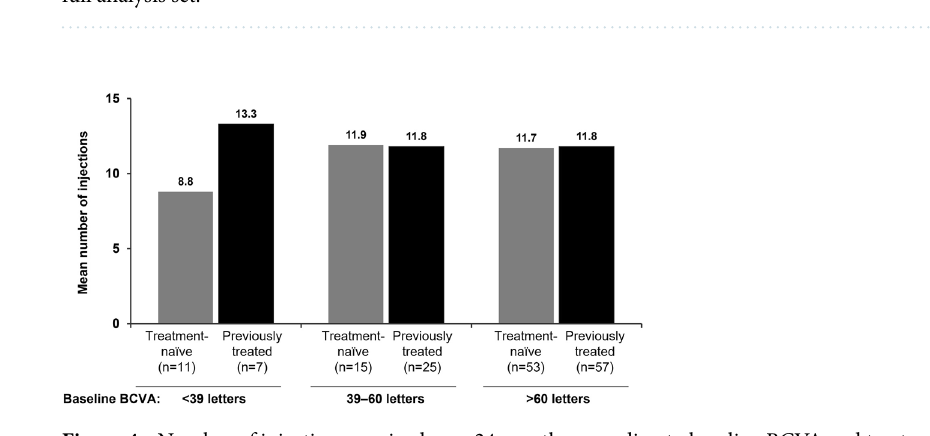
Figure 3. Mean CRT change over 24 months according to treatment cohort. Data are for all patients in the FAS with a CRT assessment at Month 24; error bars denote standard deviation. CRT, central retinal thickness; FAS, full analysis set.